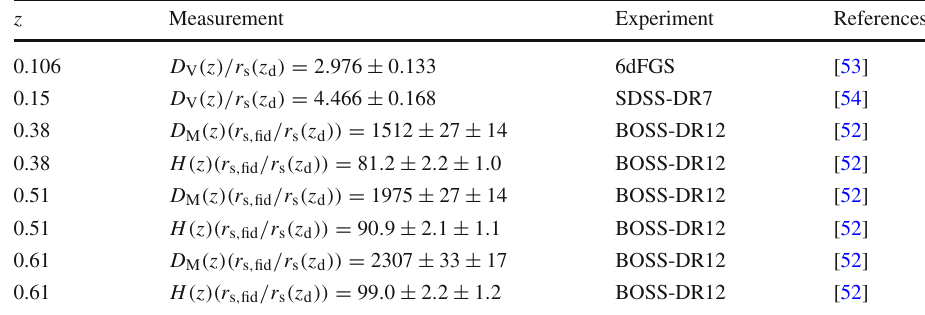
Table 1 The BAO measurements from the various surveys used in this work. The value of r s , fid = 147 . 78 Mpc is for the sound horizon for the fiducial model. Note that, for the measurements from BOSS-DR12, the first error is the statistical uncertainty, while the second value is the systematic error